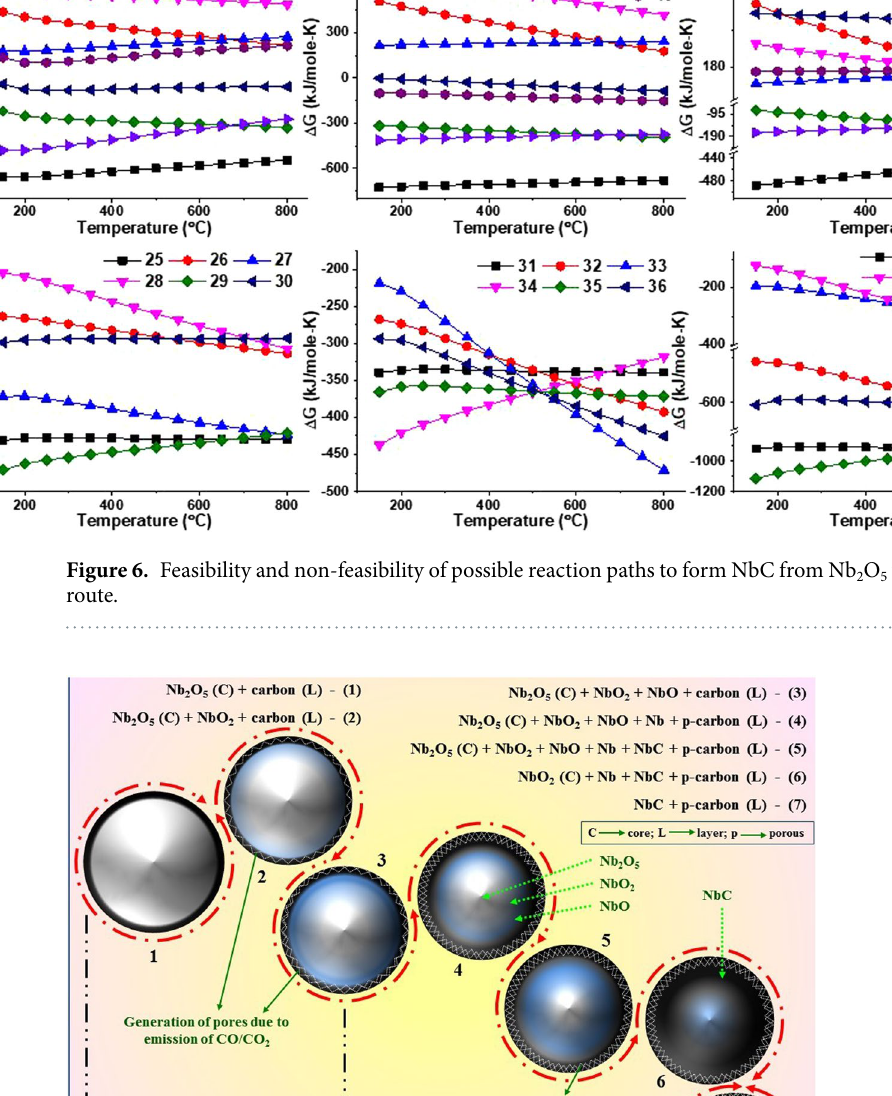
Figure 8a shows the UV-visible absorption spectra of all the samples synthesized at 800 °C suggesting broad multiple absorption humps in the visible region, which may be associated with the presence of either oxide centers (NbO 2 and Nb 2 O 5 ) or continuous carbon network (highly disordered graphic carbon) in the nanocom- posite powder samples 68–70 . The band gap for all the samples was calculated with the help of Tauc’s relationship between photon energy (h ν ) and absorption coefficient ( α ) as